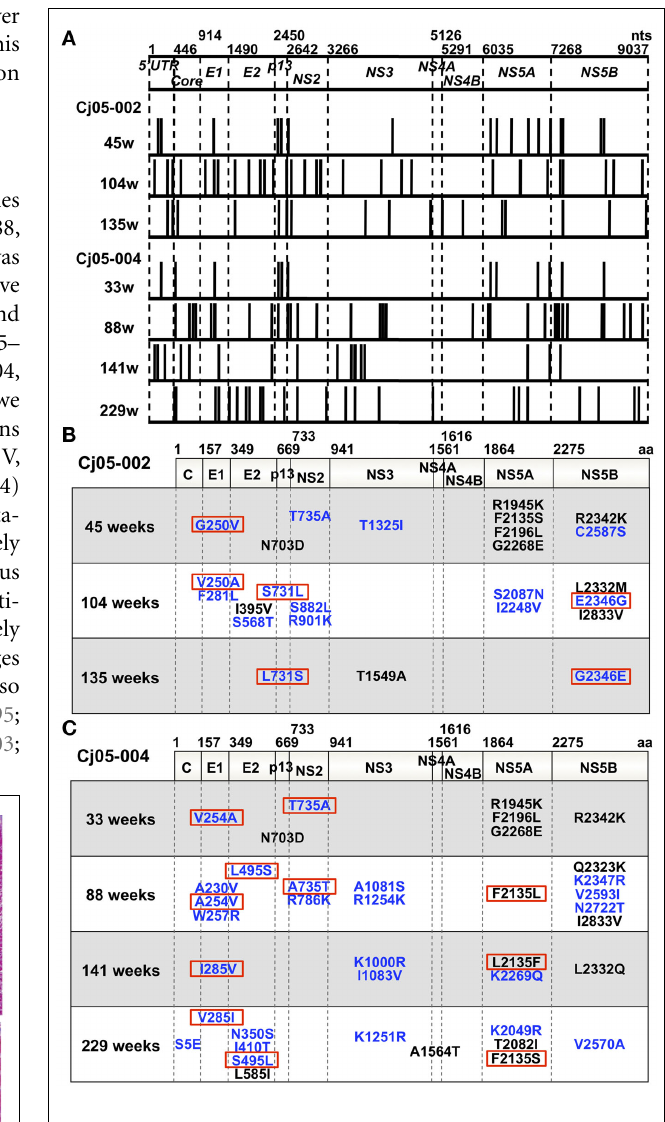
FIGURE 4 | Mutations in the viral genome sequences amplified from plasma of the marmosets persistently infected with GBV-B. (A) Positions of the nucleotide mutations in the viral genome sequences at multiple time points (at weeks 45, 104, and 135 in Cj05-002 and weeks 33, 88, 141, and 229 in Cj05-004) are illustrated as bars. (B,C) Positions of the non-synonymous mutations in the viral genome sequences at multiple time points are shown. (B) Cj05-002; (C) Cj05-004. Positions of the mutations that had been identified in previous reports are indicated as black, while those unidentified previously are shown as blue. Red squares illustrate back or sequential